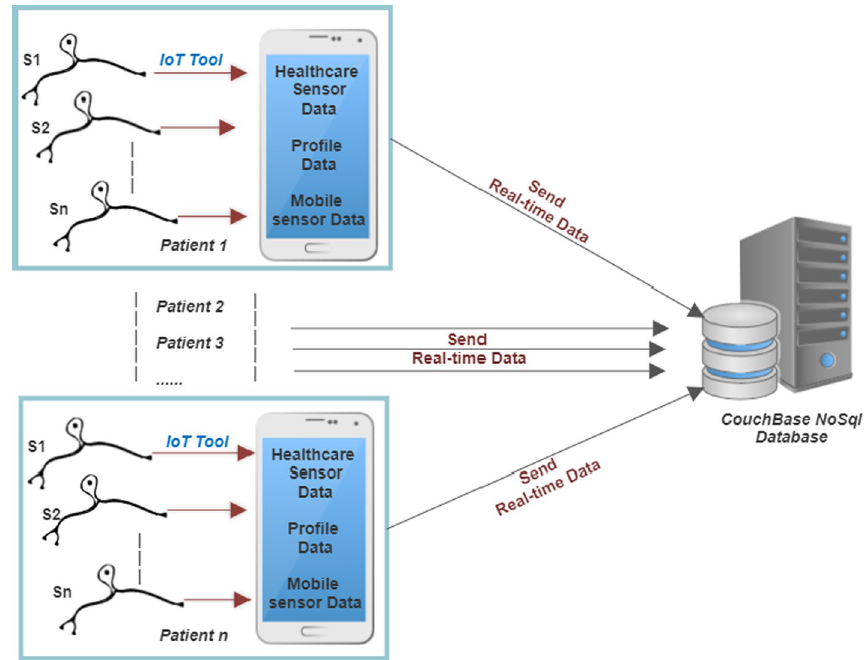
Fig. 2 Reality mining for collecting real-time healthcare data in the proposed